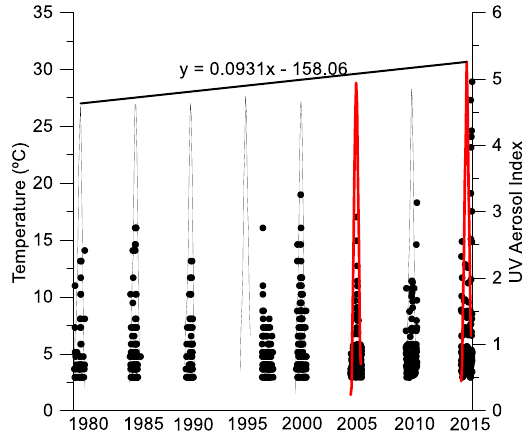
Figure 1. Environmental conditions (air Temperature (represented as lines) and UV aerosol index (represented as points)) for Sierra Nevada region (37°1 ′ , − 3°23 ′ , 37°4 ′ , − 3°17 ′ ) for 1980 to 2015 period. Diagonal line represents the temperature trend during the ice-free period and the red lines the temperature of the two years